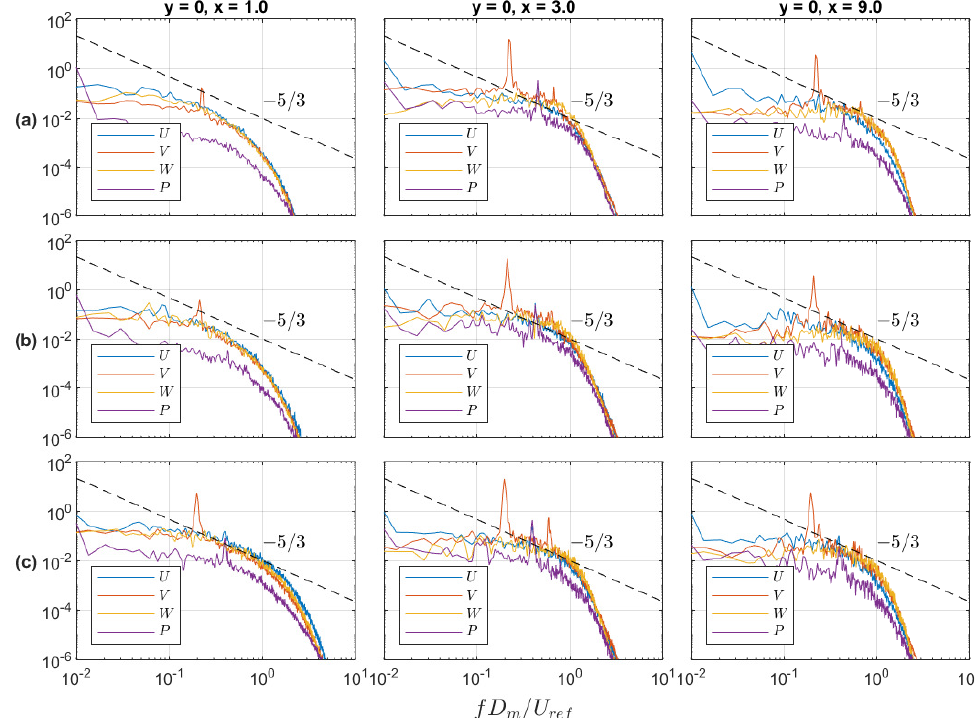
Figure 13. Energy spectrum of velocity components and of pressure at y = 0 and different x positions (see top header) for the three simulated cylinders: baseline ( a ), A03 ( b ), and A11 ( c